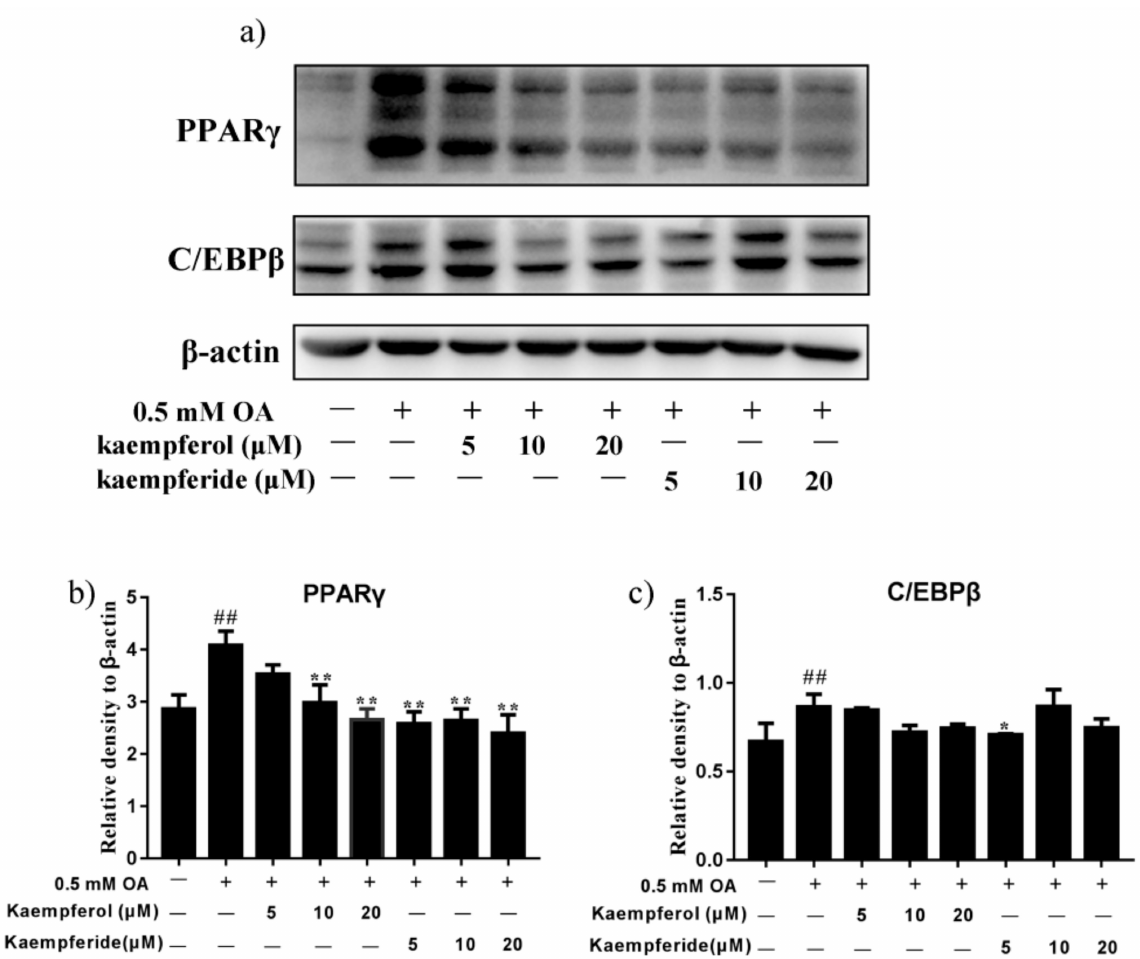
Figure 6. Kaempferol and kaempferide inhibited expression of PPAR γ and C/EBP β in OA-treated HepG2 cells. HepG2 cells were incubated with different concentrations of kaempferol or kaempferide in the presence of 0.5 mM OA for 48 h and followed by western blot analysis of the expression of PPAR γ and C/EBP β . ( a ) Representative blots. ( b ) Quantification results of the expression of PPAR γ . ( c ) Quantification results of the expression of C/EBP β . Data were expressed as mean ± SD of three independent experiments ( n = 3). ## p < 0.01, compared with vehicle-treated control cells (Con); * p < 0.05 and ** p < 0.01, compared with OA-treated cells